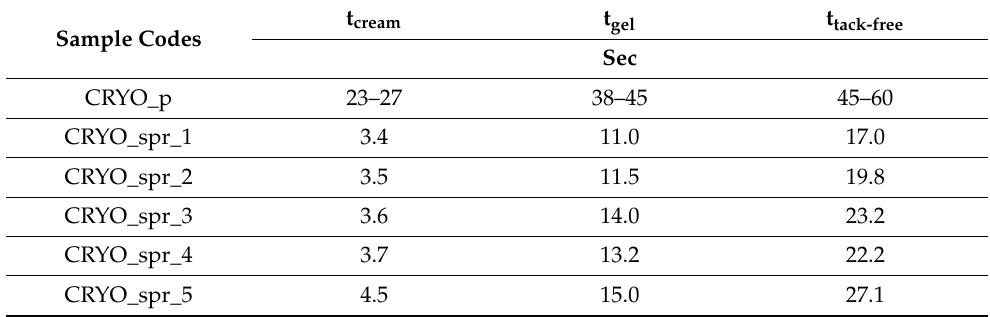
Table 4. Foaming parameters.